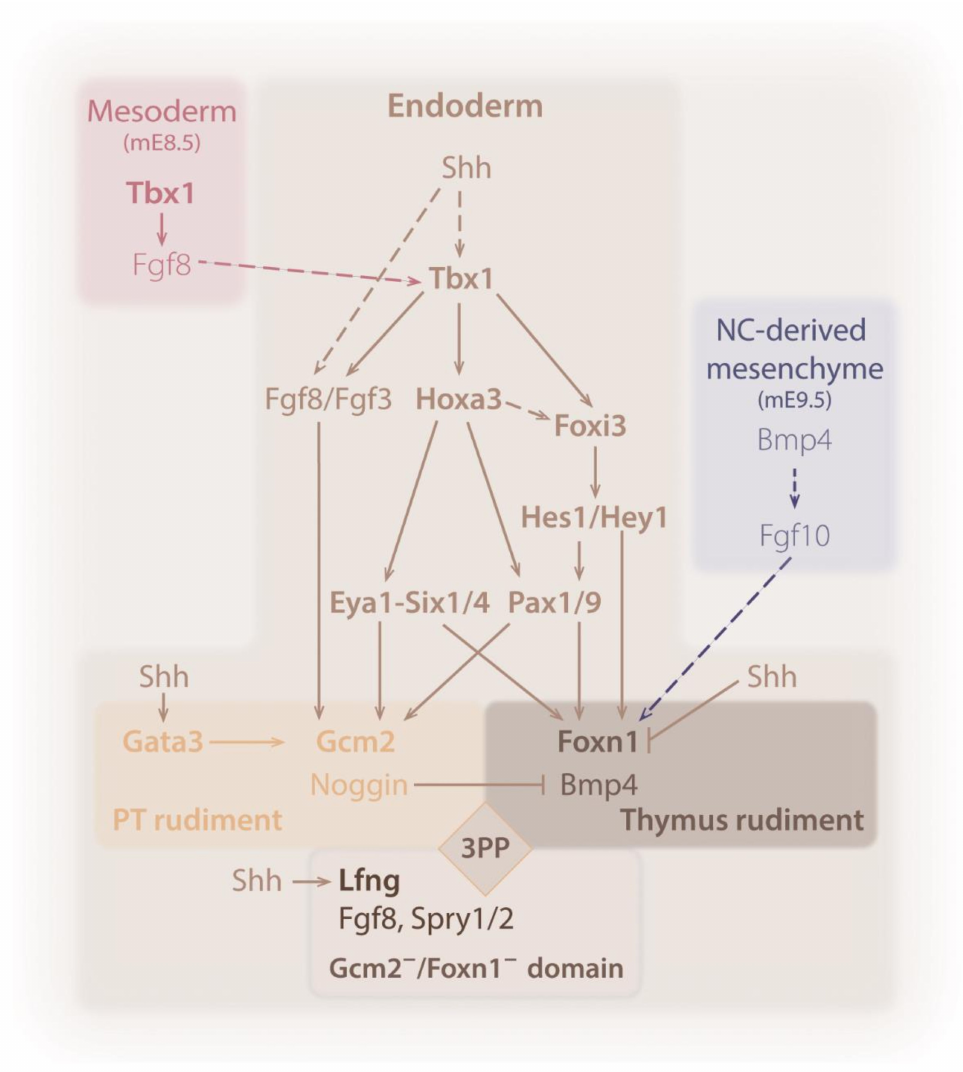
Figure 3. Schematic diagram of potential interactions of factors in the early steps of the formation of the thymus. Seemaintextfordetails. Colorcodeofthedifferenttissuecompartments: Endoderm—fromyellow to dark brown; mesoderm—rose; NC mesenchyme—blue. Solid and dashed lines indicate known and hypothetical interactions, respectively. Bold font—transcription factor. Regular font—signaling